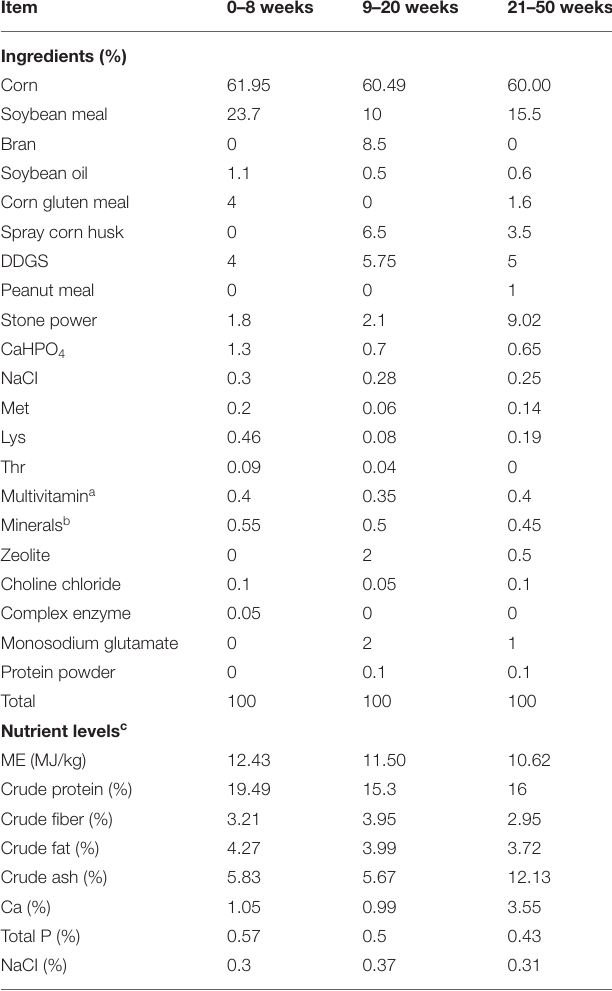
TABLE 1 | Ingredients and nutrient levels of diets used in different growth